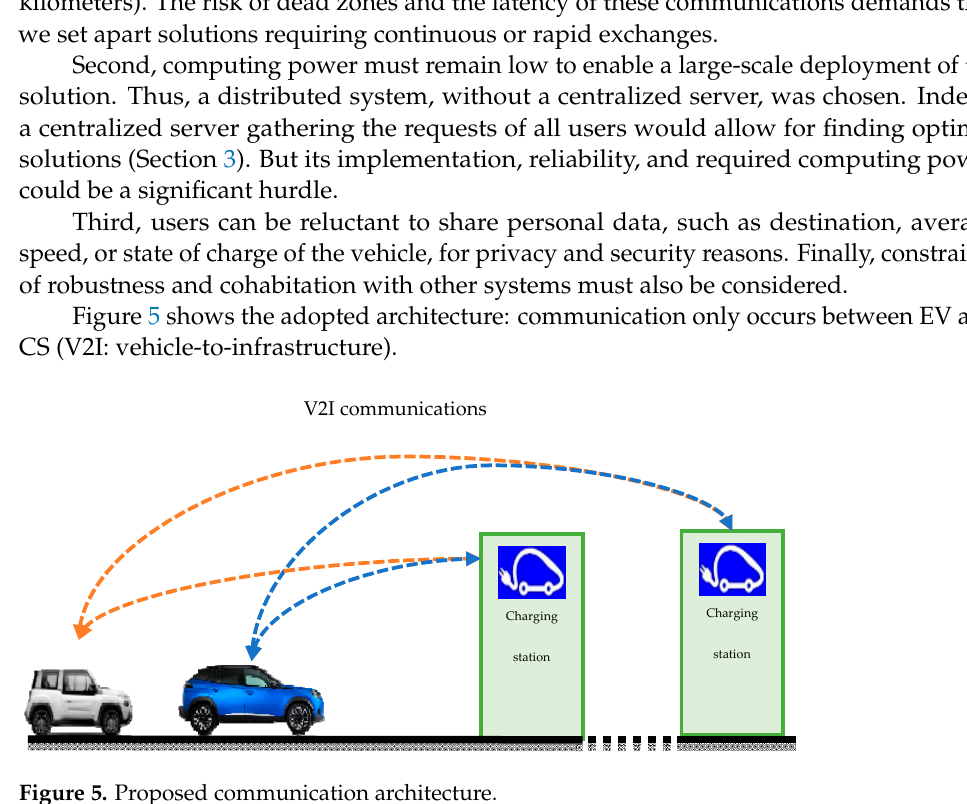
Figure 5. Proposed communication architecture.